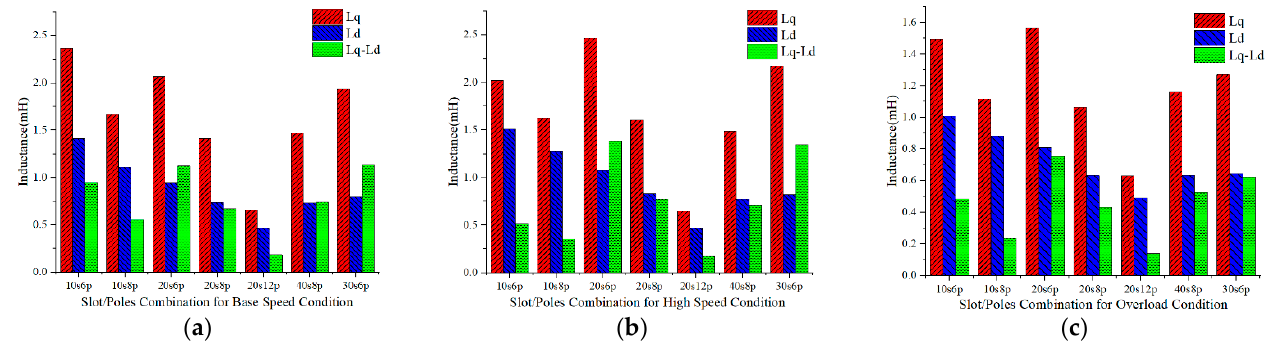
Figure 3. Inductance characteristics in different slot/pole combinations: ( a ) base speed condition, ( b ) high-speed condition, and ( c ) overload speed condition.